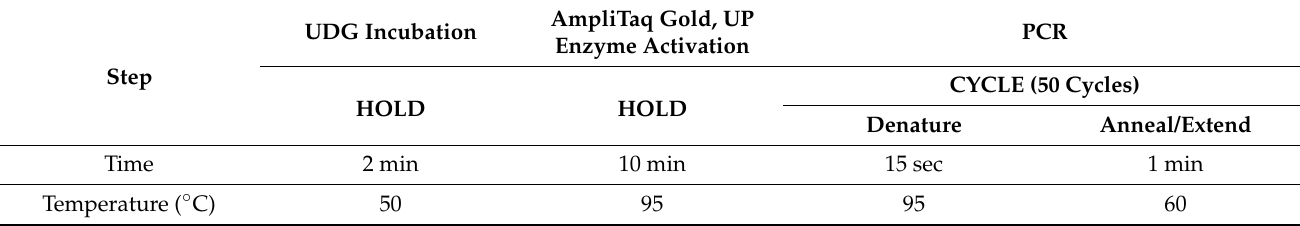
Table 3. Thermal cycling conditions for Real-Time